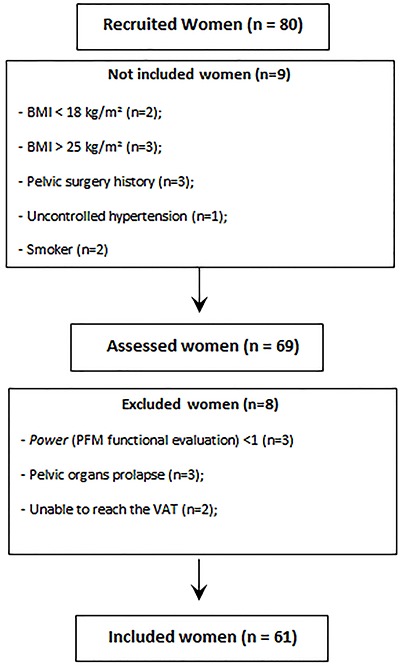
Flowchart of the participants recruited for the present study. BMI: body mass index; PFM: pelvic floor muscles; VAT: ventilatory anaerobic threshold. Twenty of these women were only recruited to evaluate the reliability of the reference equation.